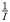
Exploration rate (1I) at different iterations in the original ALO.